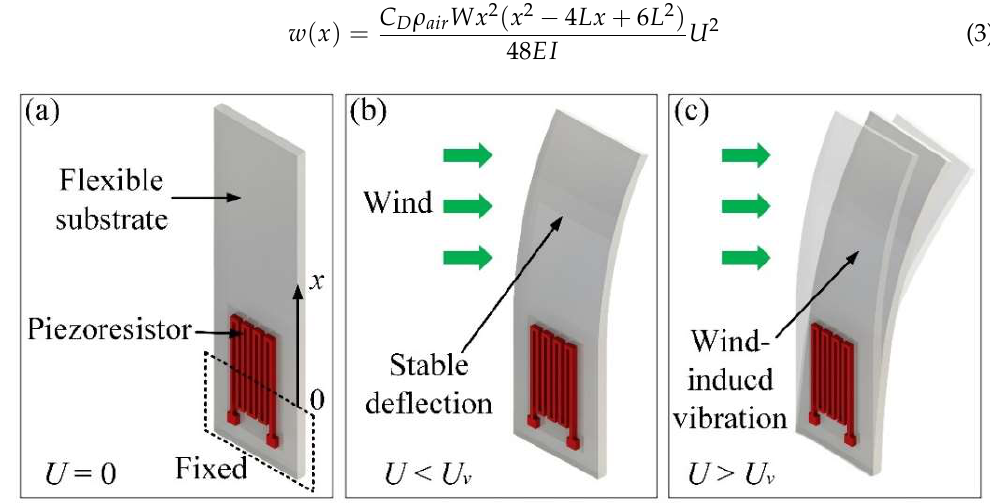
Figure 2. Schematic overview of the microcantilever anemometer under different wind speeds: ( a ) no wind, ( b ) lower than the critical speed, ( c ) higher than the critical speed.